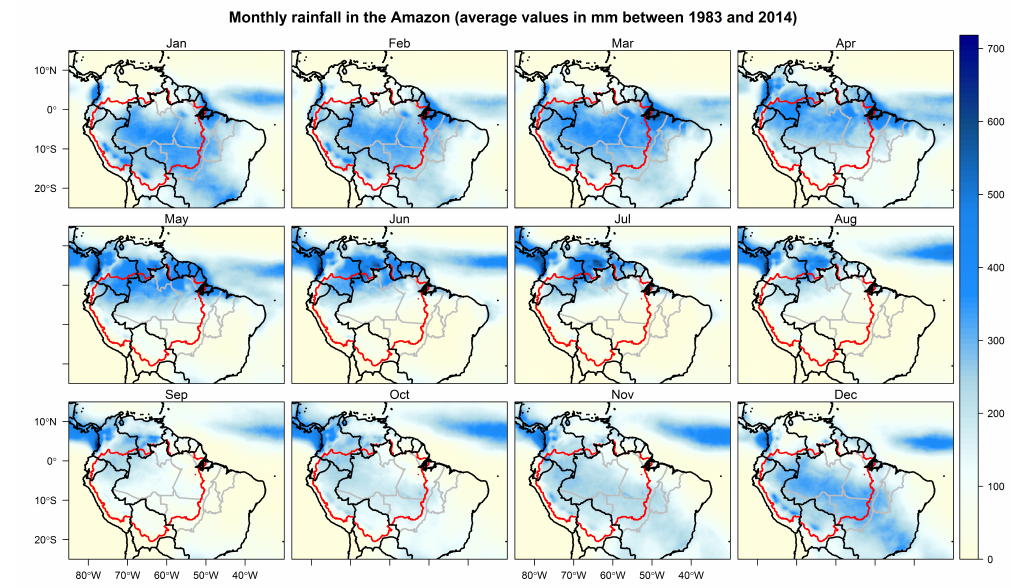
Figure 3. Mean monthly rainfall (mm) in the Amazon basin (red) for the 1983–2014 time period computed from PERSIAN-CDR